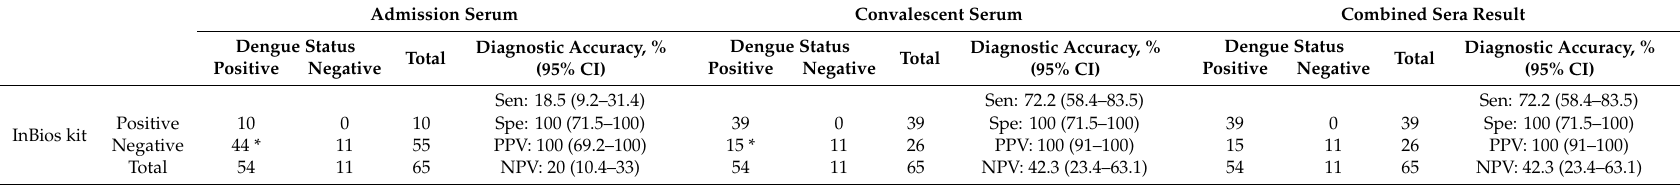
Table 3. Accuracy of InBios ELISA for dengue diagnosis for patients from Panel